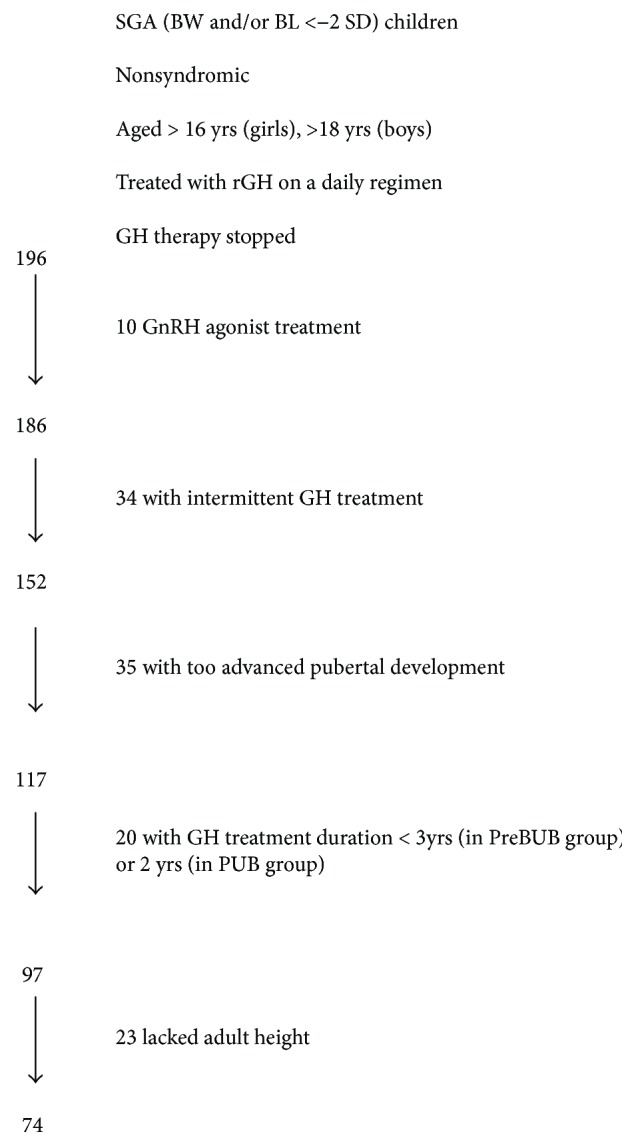
Patients selection flowchart.